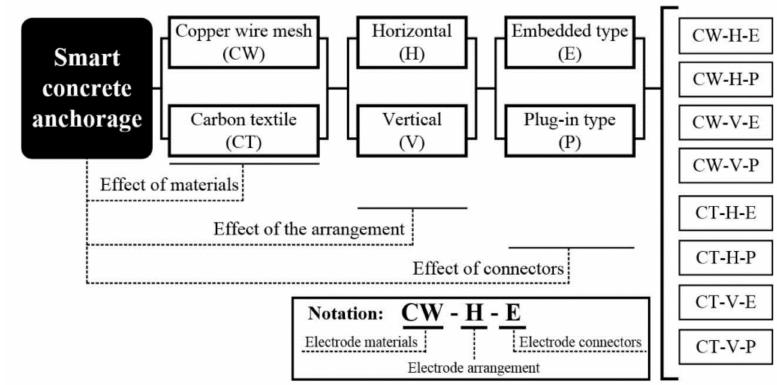
Figure 2. Experimental